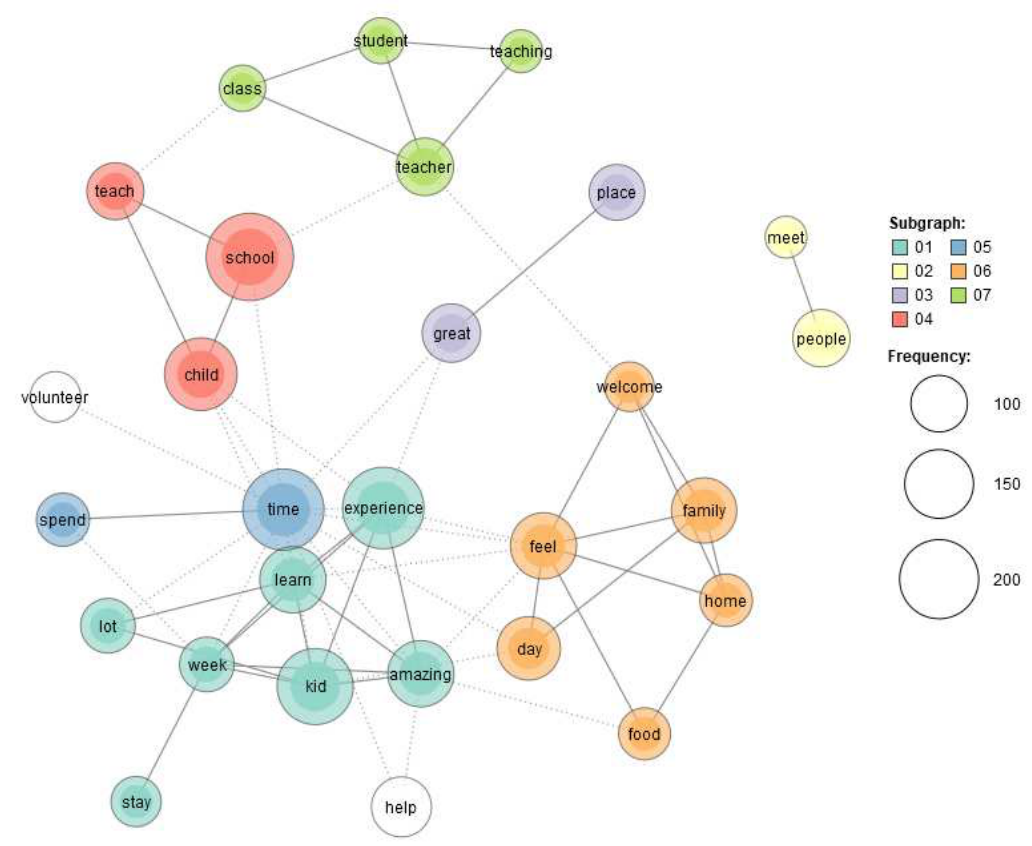
Figure 3b. Co-occurrence network of words (Cambodia data